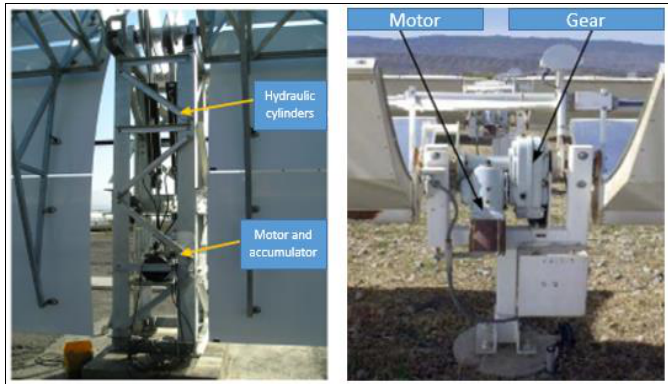
Figure 2: Basic elements of a PTC. Source: Taken from